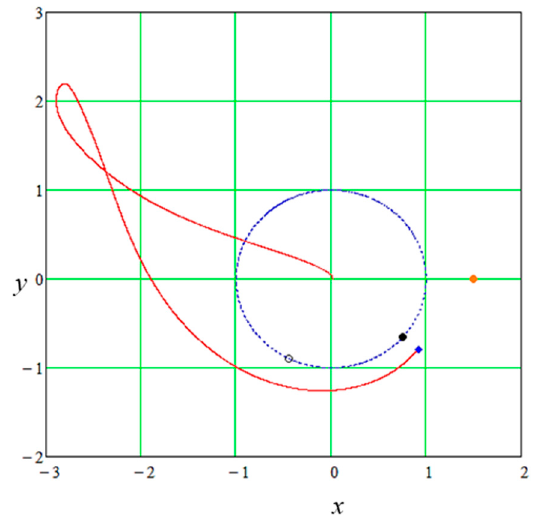
Figure 3. The trajectory of the of the SC obtained from solving the problem of the first stage; represented in the axes of a uniformly rotating CS xCy ( z ).